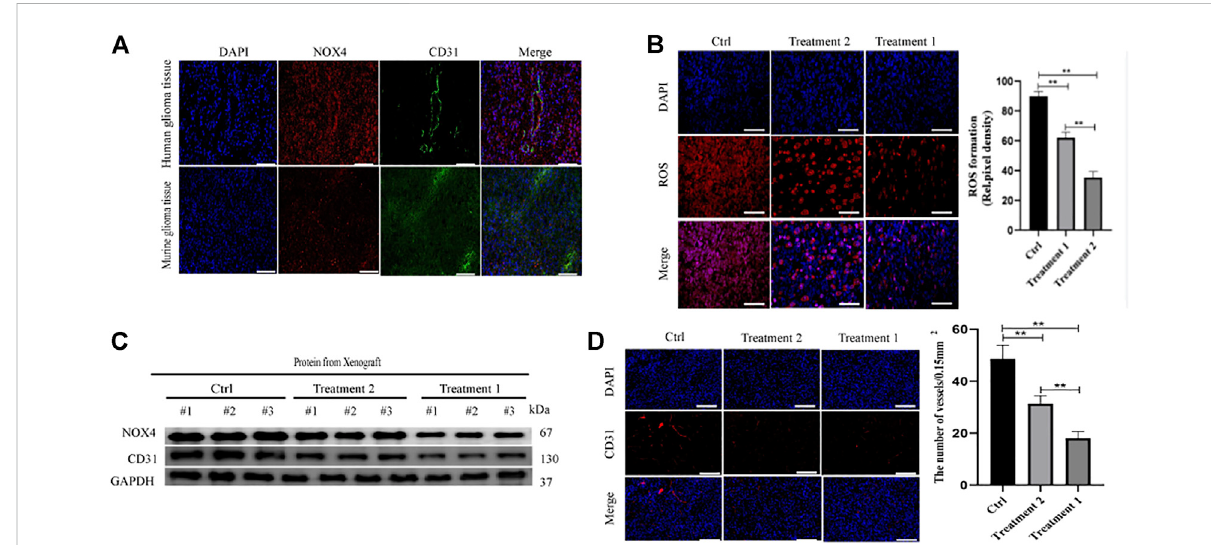
FIGURE 3 Nox4inducedangiogenesisinaROSdependentmanner (A) BothhuamnandmurinegliomatissuesinanintracranialXenograftmodelwereco- stained by immuno fl uorescence for-anti-NOX4- (red), anti-CD31 − (green), showing NOX4 expression(red) in endothelia (green). Scale bars, 50 μ m; (B) Representative images of ROS production. Scale bars, 50 μ m; (C) Western blot analysis of the levels of the angiogenesis-associated protein (CD31)andNOX4ingliomatissues; (D) RepresentativeimmunohistochemicalanalysisofCD31expressioninintracranialXenografttissue.Scale bars,50 μ